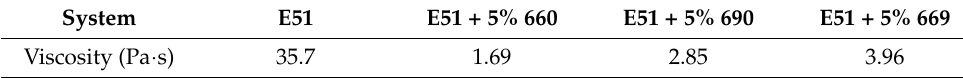
Table 2. Viscosity of E-51 epoxy resin after adding 5% wt viscosity reducer.